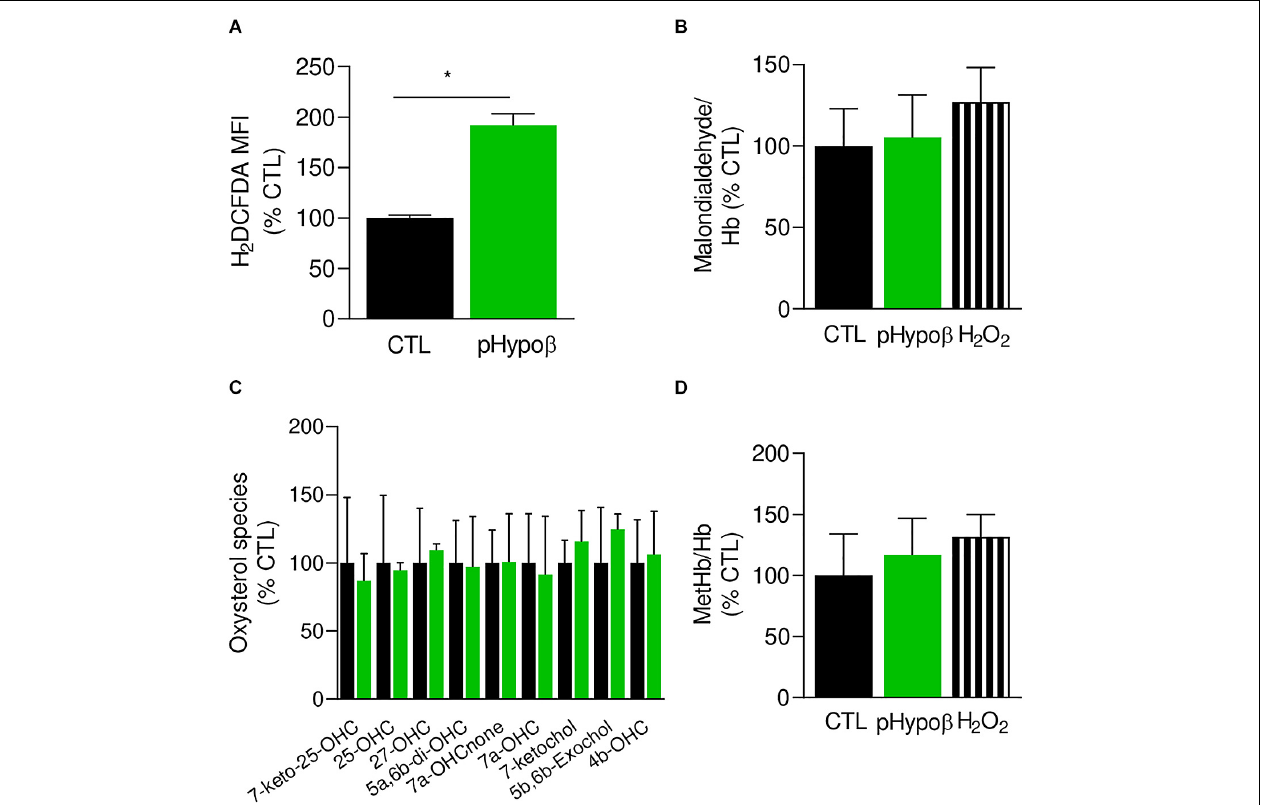
FIGURE 5 | Accumulation of free reactive oxygen species in pHypo β RBCs is not accompanied by lipid or hemoglobin oxidation. RBCs from healthy donors (black columns) or pHypo β (green columns) were evaluated for free reactive oxygen species (ROS) accumulation (A) , lipid peroxidation (B) , oxysterol content (C) , and methemoglobin (MetHb) accumulation (D) . Hydrogen peroxide was used as positive control in (B,D) (hatched columns). All data are expressed as percentage of healthy untreated RBCs. (A) Intracellular ROS accumulation. RBCs were labeled with the non-fluorescent H 2 DCFDA which is transformed into fluorescent DCF inside the RBCs after de-esterification and interaction with ROS. Flow cytometry analysis allowed to determine the MFI of the global RBC population. Data are means ± SEM of 3–6 independent experiments. Mann–Whitney test; * p < 0.05. (B) Lipid peroxidation. Malondialdehyde (MDA), one final product of lipid peroxidation, was detected through interaction with thiobarbituric acid forming a fluorescent adduct. MDA levels were normalized to Hb content and data are means ± SD of triplicates from 2 independent experiments. (C) Membrane content in oxysterols. RBCs were washed, lysed, extracted for lipids and determined